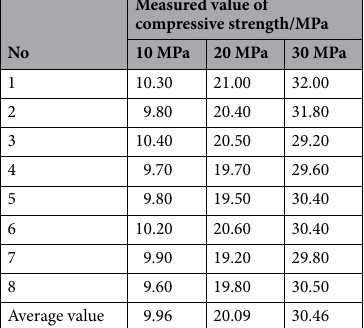
Measured value of compressive